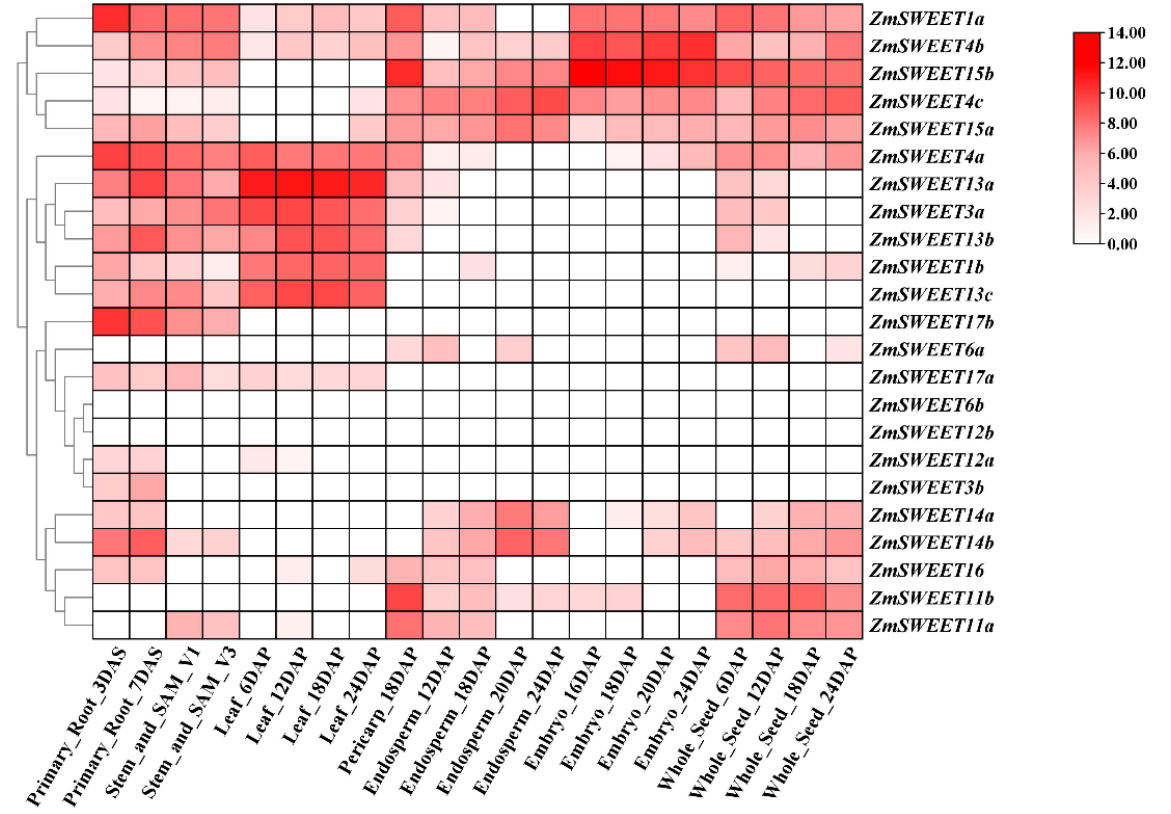
Figure 6. Expression profiles of maize SWEETs in different tissues. Log 2 -based fold change data were used to create the heatmap. Fold changes in gene expression are indicated by the color scale. DAS: Days of growth after sprouting. DAP: Days after pollination.